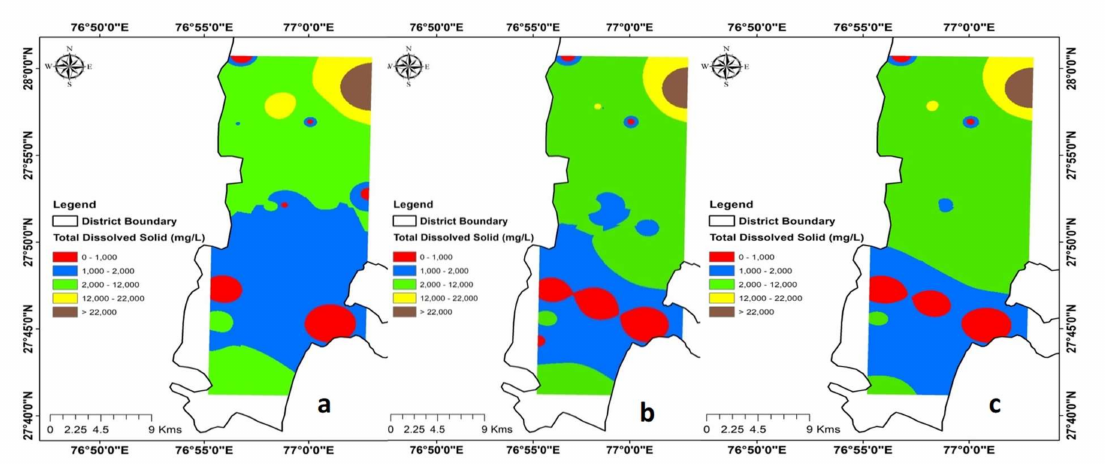
Figure 4. Total dissolved solids (TDS) maps ( a ) pre-monsoon ( b) monsoon ( c ) post-monsoon.